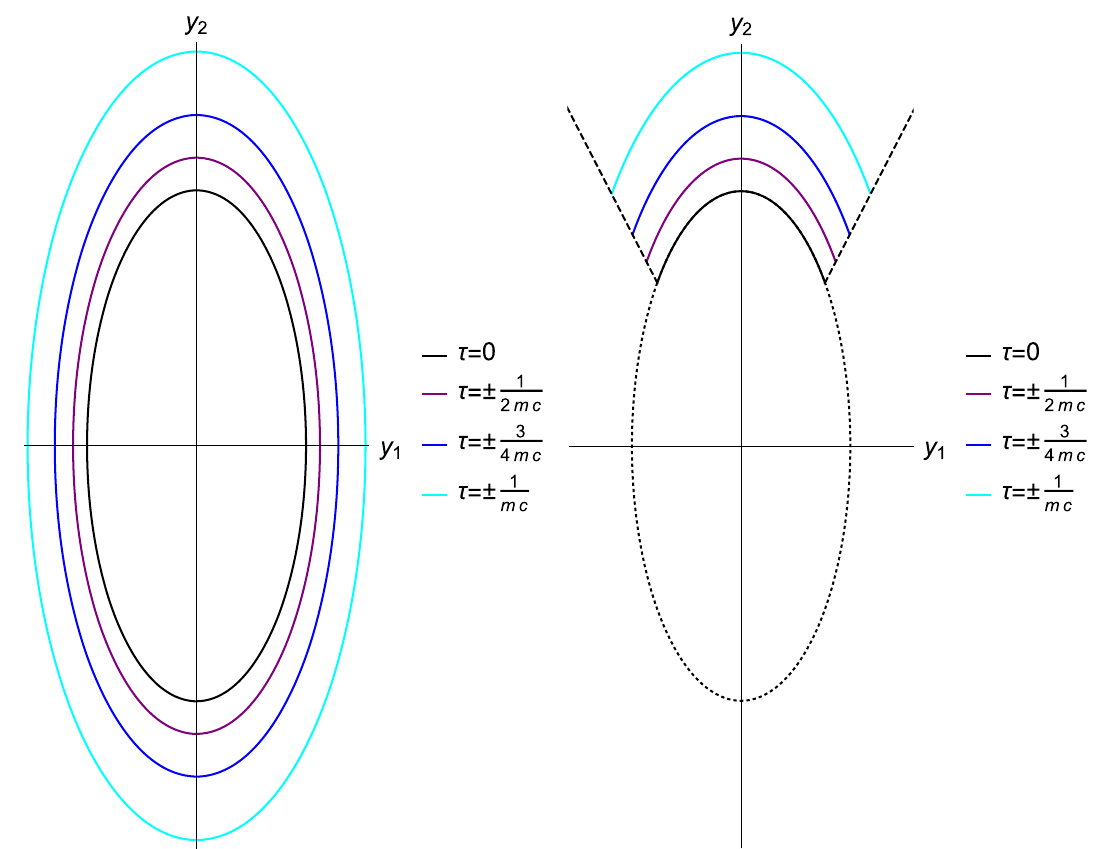
Fig. 1 Indicative static solutions of the SL ( 2 , R )/ U ( 1 ) V model. The left panel corresponds to a rotating solution, while the right one to an oscillating solution, which is a folded string. Notice that as λ > 0 the